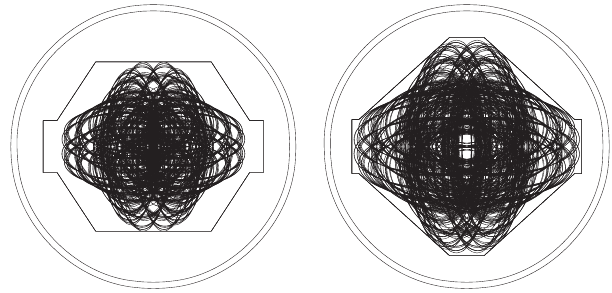
FIG. 14. FCC-hh beam screen (left) and the new design proposal (right) with beam ellipses superimposed. The beam ellipses are calculated for the magnetic elements in the regular arc cell and the IR5 DS, for the 18 × 90 cell layout at 450 GeV beam energy and a relative momentum offset of 3 . 1 × 10 − 4 . The number of betatron sigmas used is equal to the corresponding minimum BSC value within the range of beam